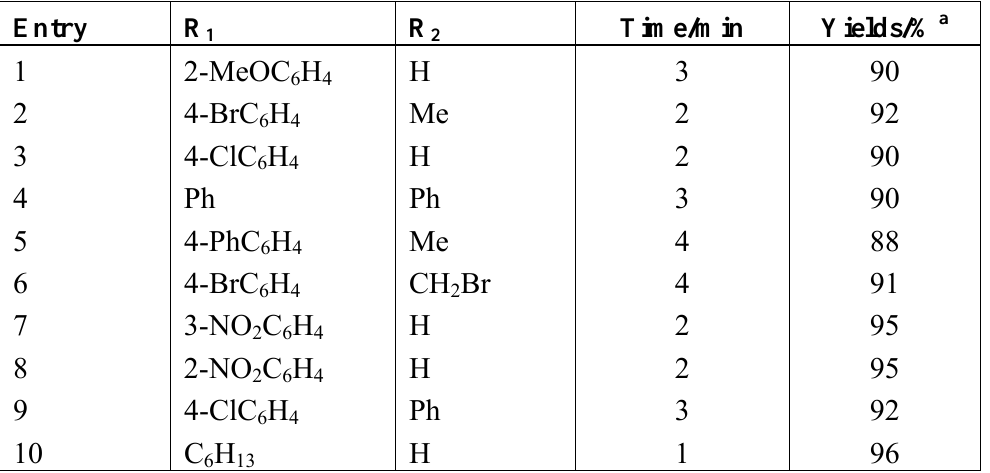
Table 1. Deprotection of 1,3-dithiolanes, and 1,3-dithianes with Hg(NO ) •3H O in a solventless system with (1:2 molar ratios, 3 2 2 100% conversion).